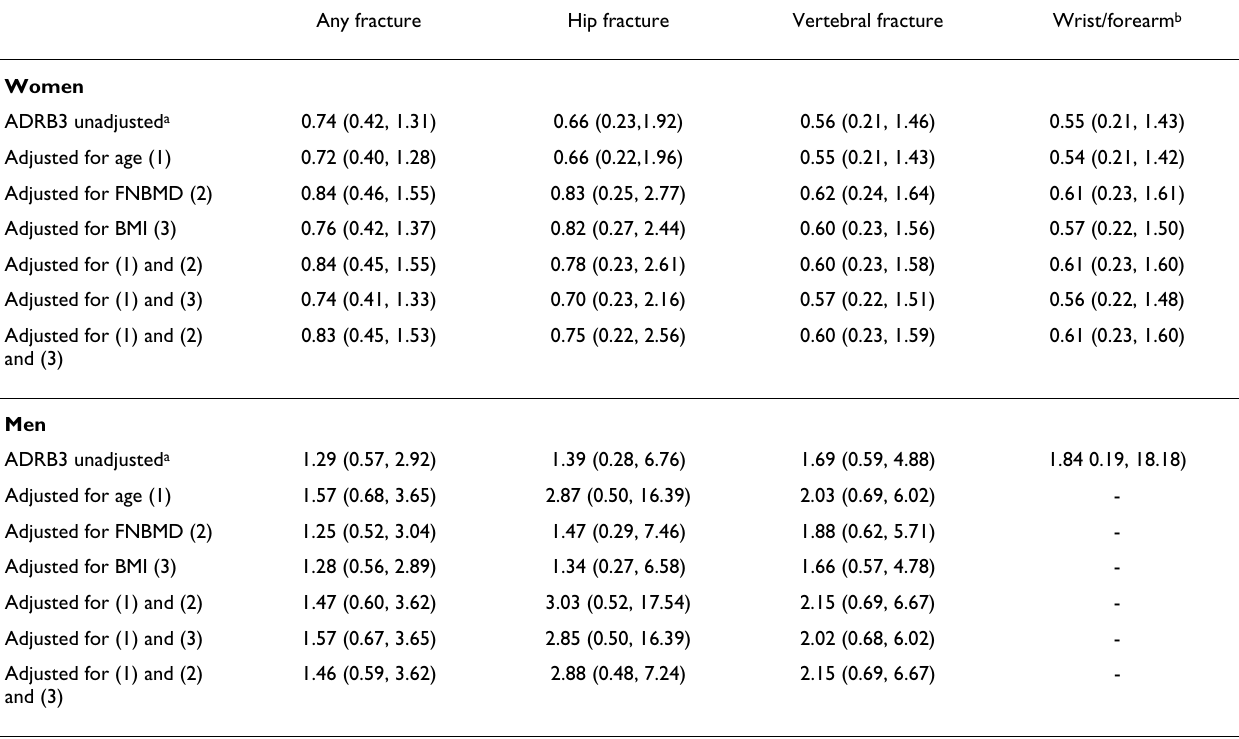
Table 5: Relationship between β 3-Adrenergic Receptor genotypes and fracture risk